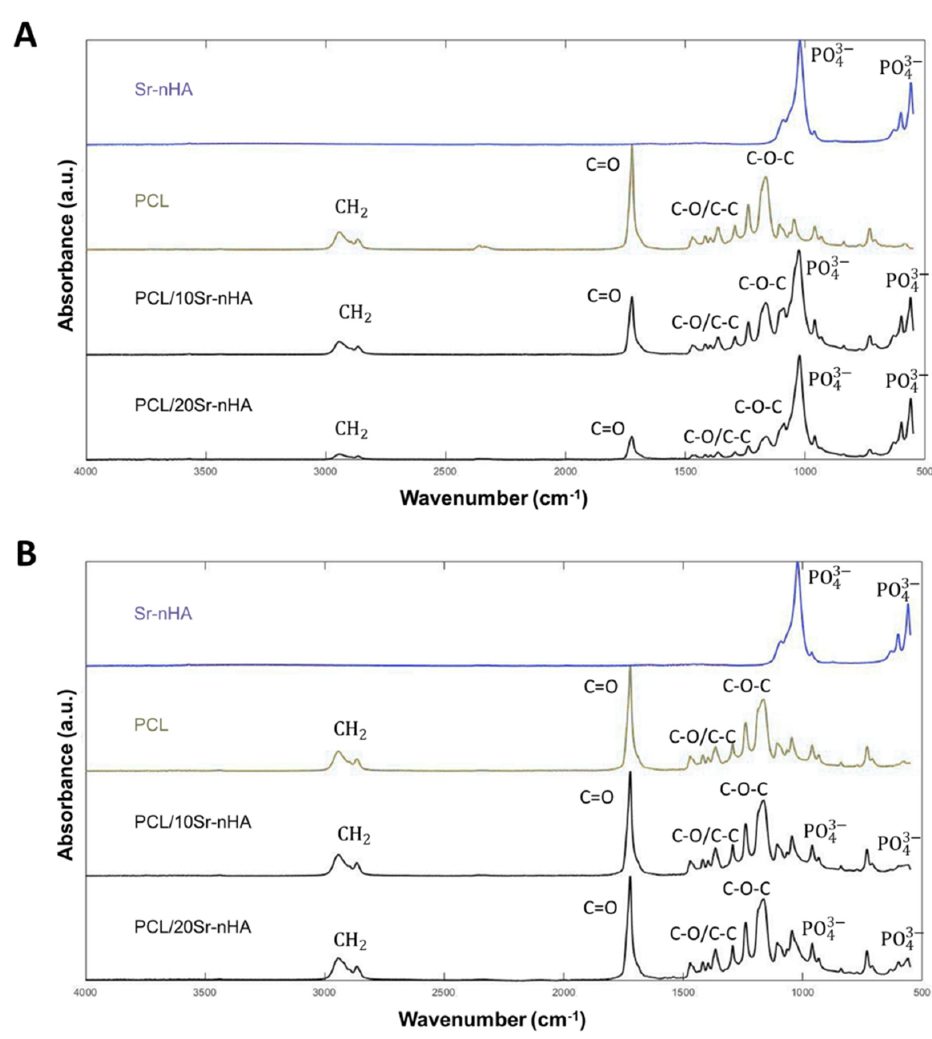
Figure 2. FTIR spectra of ( A ) raw powders and ( B ) extruded filaments deriving from the additive manufacturing process (spectra of Sr-nHA powder is included for comparison purpose).